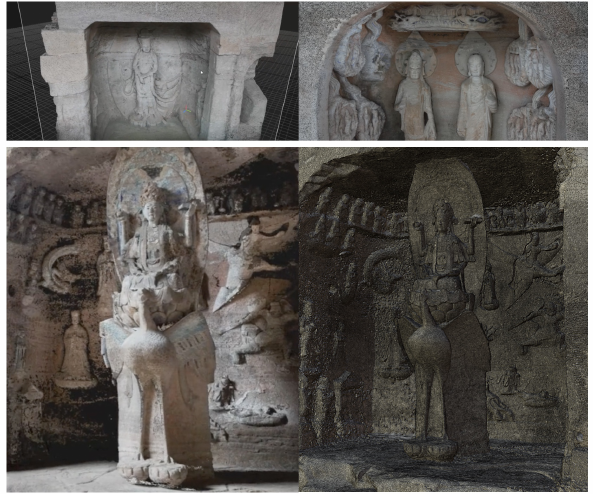
Figure 3: Digital documentations of the Esoteric deities (Bodhisattva, Ksitigarbha, and Peacock Radiant Wisdom King) at Dazu Rock Carving in Sichuan Province, China.